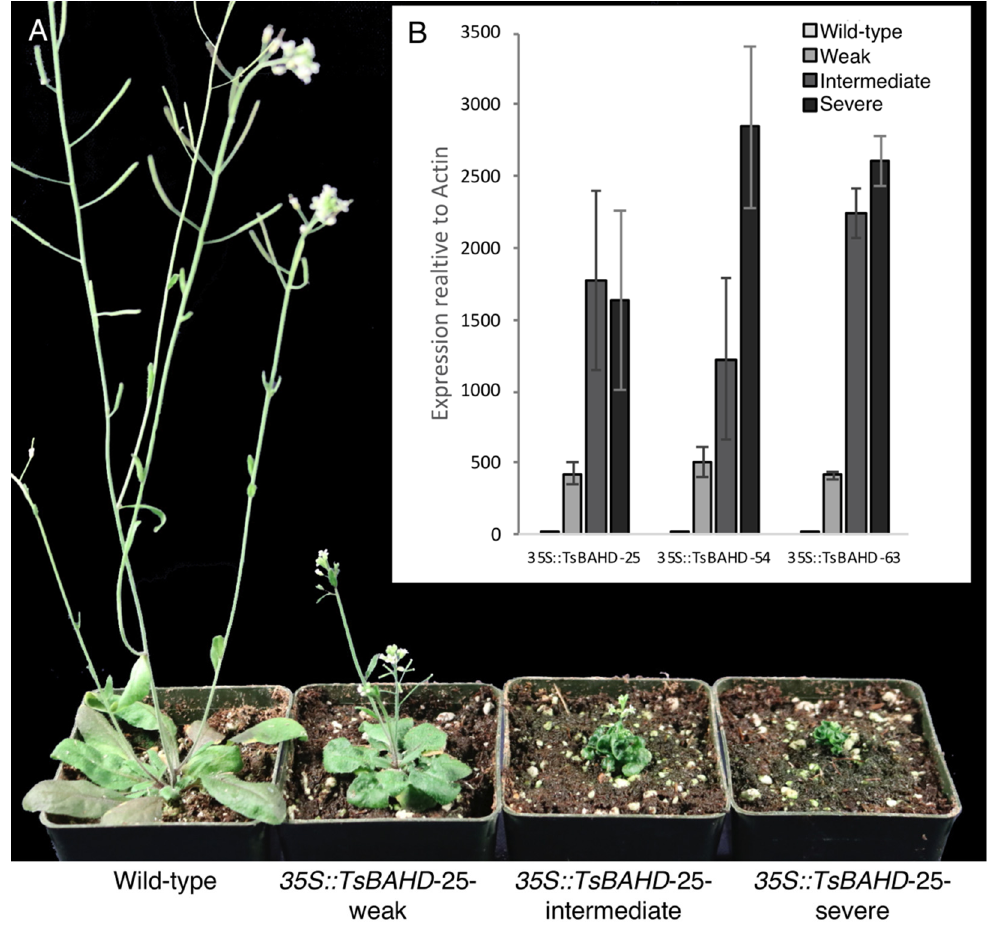
Figure 3. Phenotypes and expression of 35S::TsBAHD -25 in A. thaliana normalized to the actin 8 (At1g4920) housekeeping gene. ( A ) From left to right: six week old plants of wild type (Col-0) compared to three 35S::TsBAHD (line 25) transformants showing weak, intermediate, and most severe dwarf phenotypes. ( B ) Expression of 35S::TsBAHD lines 25, 54, and 63 in S, I, and W dwarfs compared to the wild type. Wild-type samples were included as a negative control. Errors bars represent standard error.